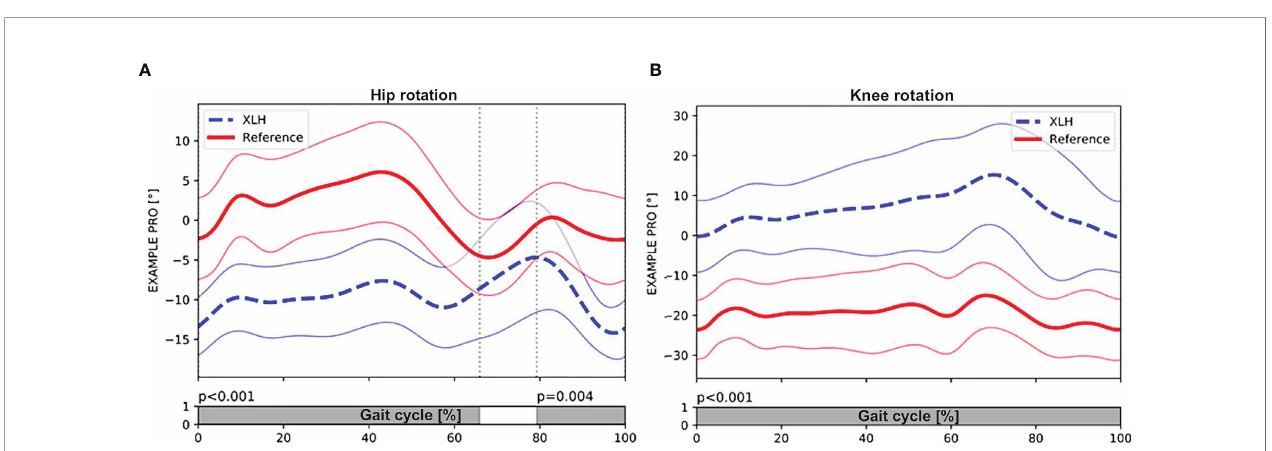
FIGURE 3 | Patients with XLH (n = 29 patients) (dotted blue line, + 1SD) had signi fi cant external rotation of the hip during stance (p < 0.001) and swing phase (p = 0.004) compared with the control group (solid red line, + 1 SD) (A) . (B) also showing signi fi cant internal rotation of the knee during the whole gait cycle (p < 0.001). Gray bar indicates the level of signi fi cance (p < 0.005) between the group with XLH and the control group during the gait cycle. Meanwhile, the white bar indicated non-signi fi cance (p >